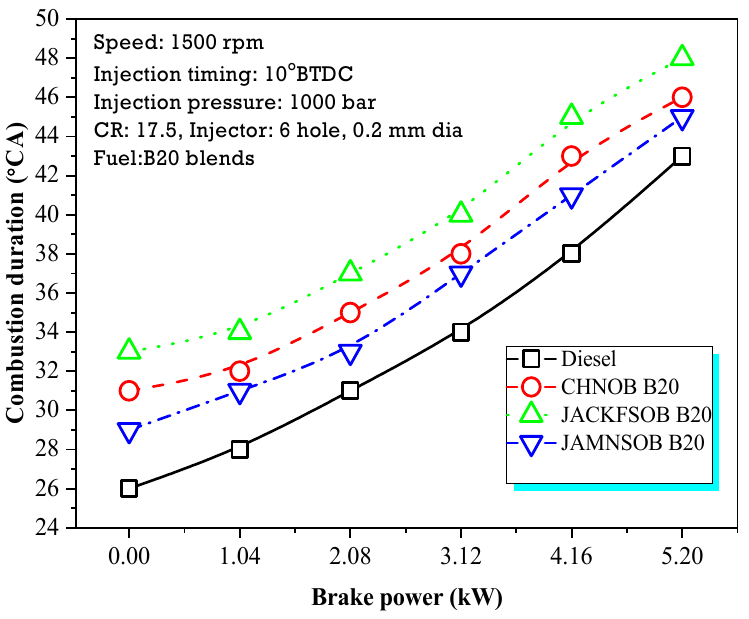
Figure 13. Variation of CD vs. BP.